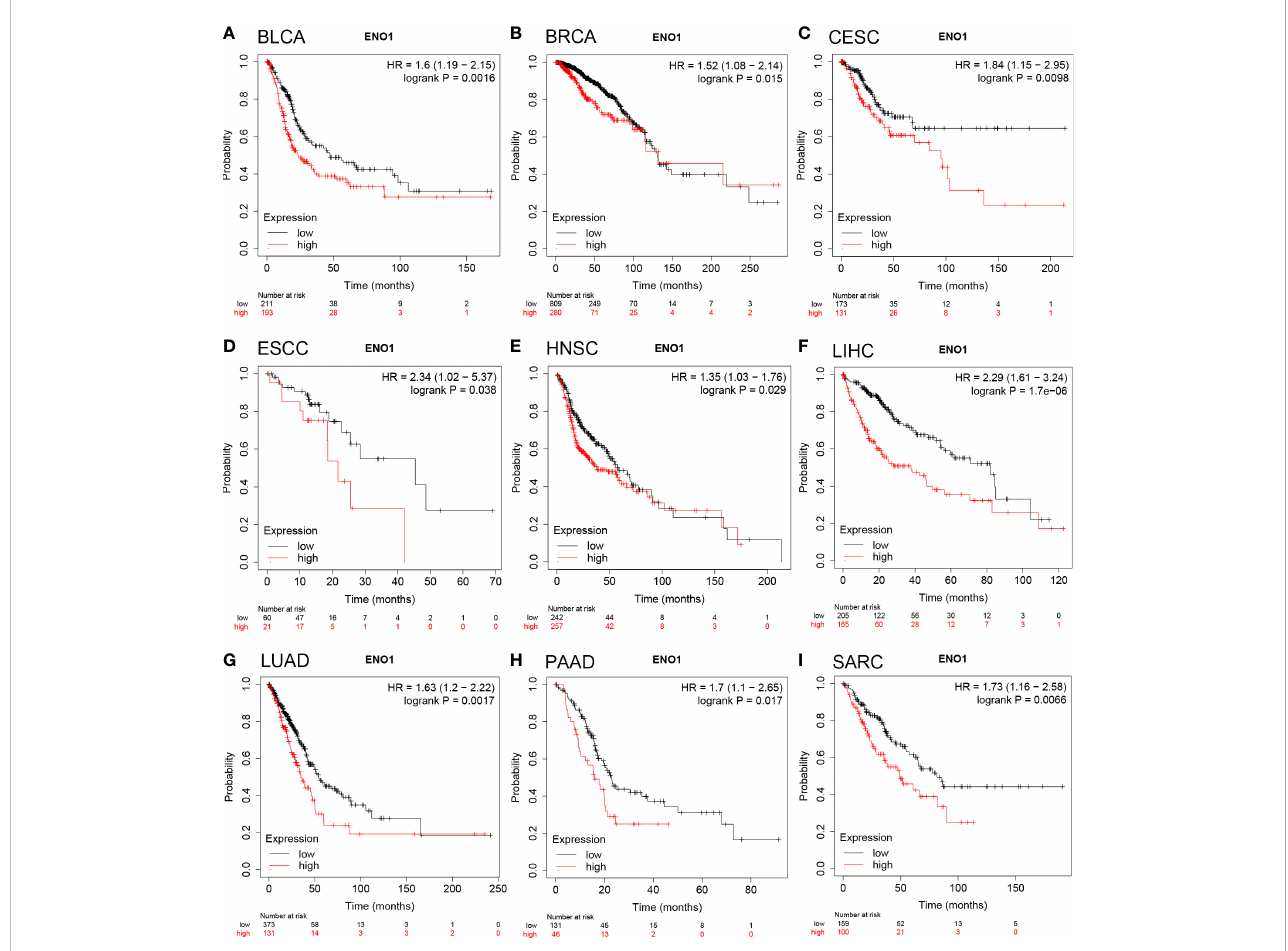
FIGURE 2 Overall survival of cancer patients was associated with high expression levels of ENO1 as analyzed by the Kaplan-Meier plotter database. (A – I) High ENO1 expression levels were related to worse overall survival in BLCA (n = 404), BRCA (n = 1089), CESC (n = 304), ESCC (n = 81), HNSC (n = 499), LIHC (n = 370), LUAD (n = 504), PAAD (n = 177) and SARC (n =